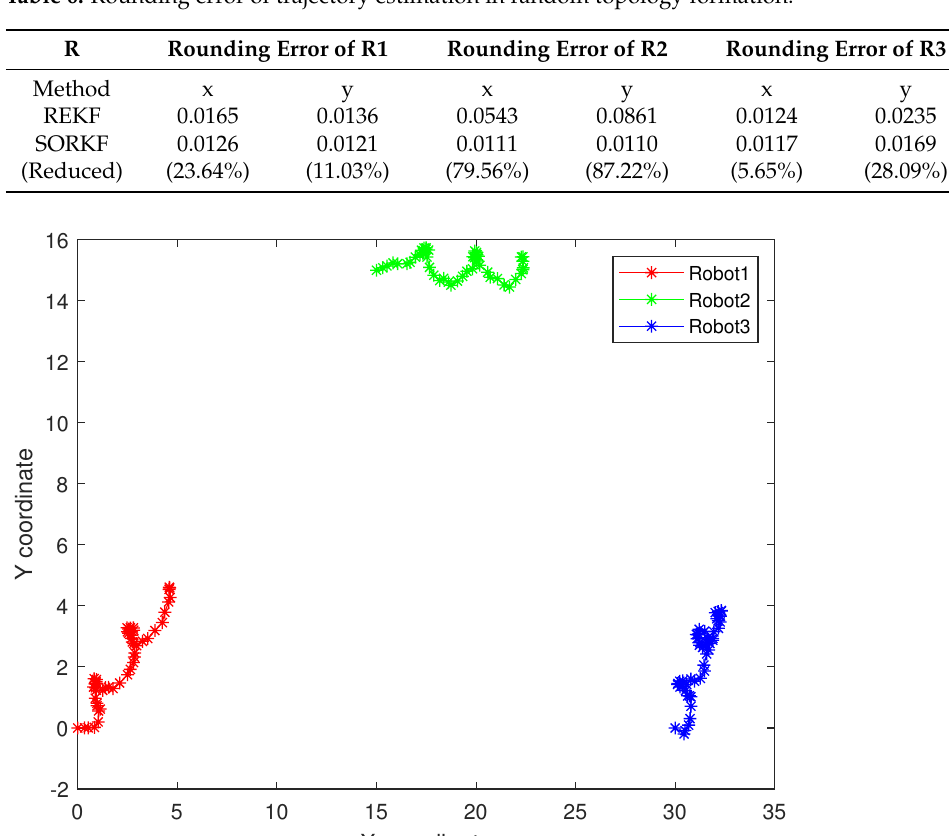
Table 6. Rounding error of trajectory estimation in random topology formation.